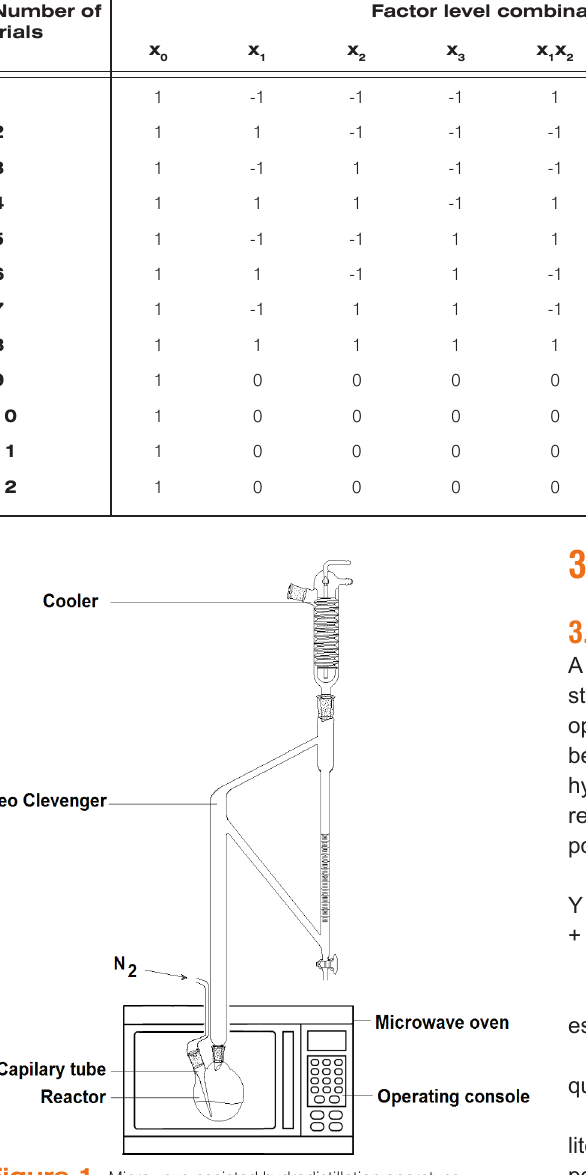
Figure 1. Microwave-assisted hydrodistillation